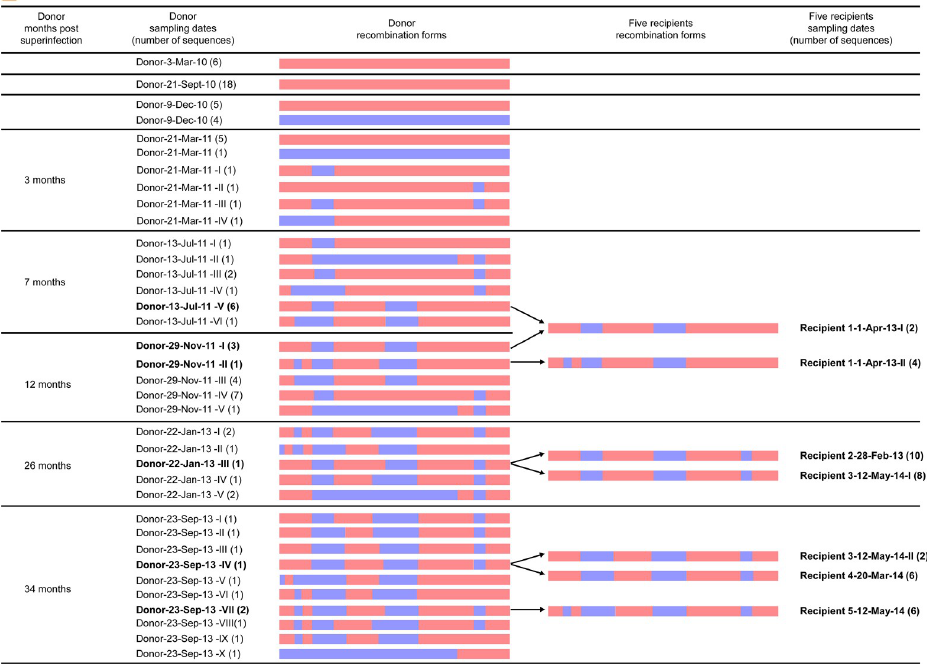
Fig 3. Recombination structure analysis of 3’ half genome sequences (HXB2: 4950-9589nt) from one HIV- 1-superinfected donor and five HIV-1 CRF01_AE/CRF07_BC infected recipients. The first column represents the time interval from the first detection of superinfecting virus to this sampling date. The second and fifth columns represent the sampling dates of the donor and five recipients, respectively. The third and fourth columns described the recombination forms of the donor and five recipients, respectively. The sequence name is composed of patient’s ID + sampling date + recombination forms + (the number of sequences with identical recombination forms at this time point). The different recombination forms at each sampling date are marked by Roman numerals. Initial CRF01_AE strains and superinfecting CRF07_BC strains were marked as light-coral and slate-blue, respectively. The arrow indicates similar or identical recombination structures were identified between the donor and 5 putative